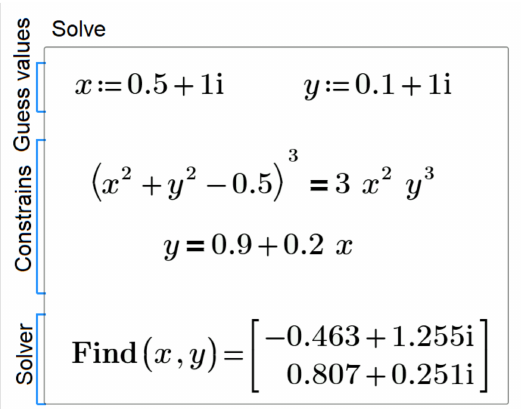
Figure 14. Code of the Mathcad program to find the complex roots of system (2).